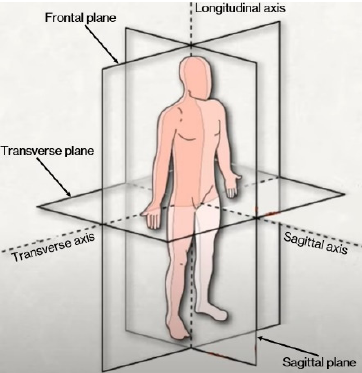
Figure 3. Reference Cartesian System used for electrodes positioning. Two frontal planes (anterior and posterior) are defined in Figure 4. The planes identify the two planes tangent to the anterior and posterior surfaces of the knee. In Figure 4, the surface R is defined as the projection of the patella in the anterior frontal plane. The points A FA and B FA are identified as the intersection of the longitudinal axis with the R surface contour; the point B FP is identified as the orthogonal projection of the point B FA in the frontal posterior plane. Rear-front configuration (Figure 5A): A − is centered in A FA with the longer side parallel to the transverse axis and V − is placed 1 cm below. A + is centered in B FP and V + is placed 1 cm above. The measurements were realized for both the knees to compare the impedance variation from knee with healthy and infected prosthesis.